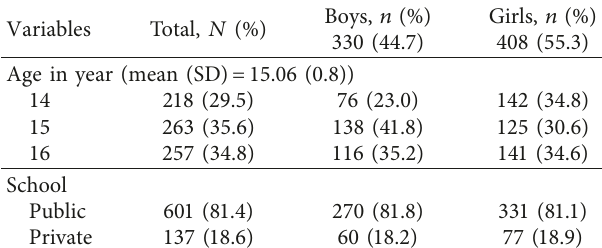
Table 1: Demographic characteristics of the students ( N � 738).